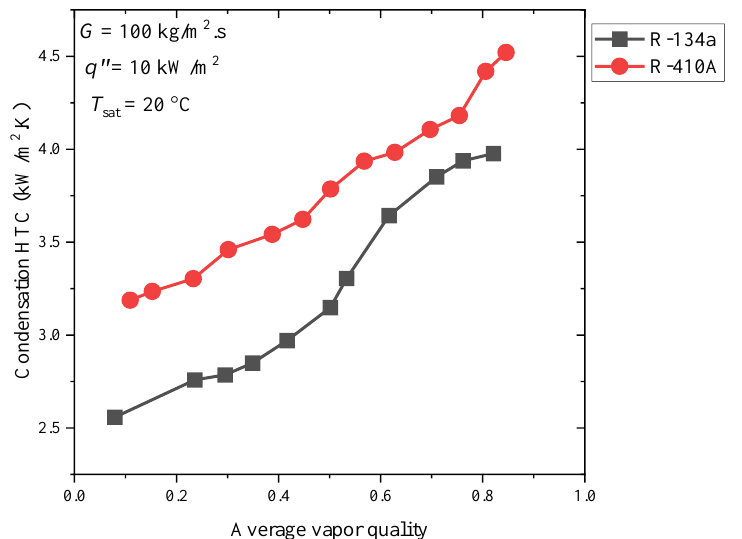
Figure 16. Comparative condensation heat transfer performance of R-134a and R-410A inside the plate heat exchanger. Solid and rectangular solid connected line presents the Kuo et al. [73] and Yan et al. [74] study respectively.